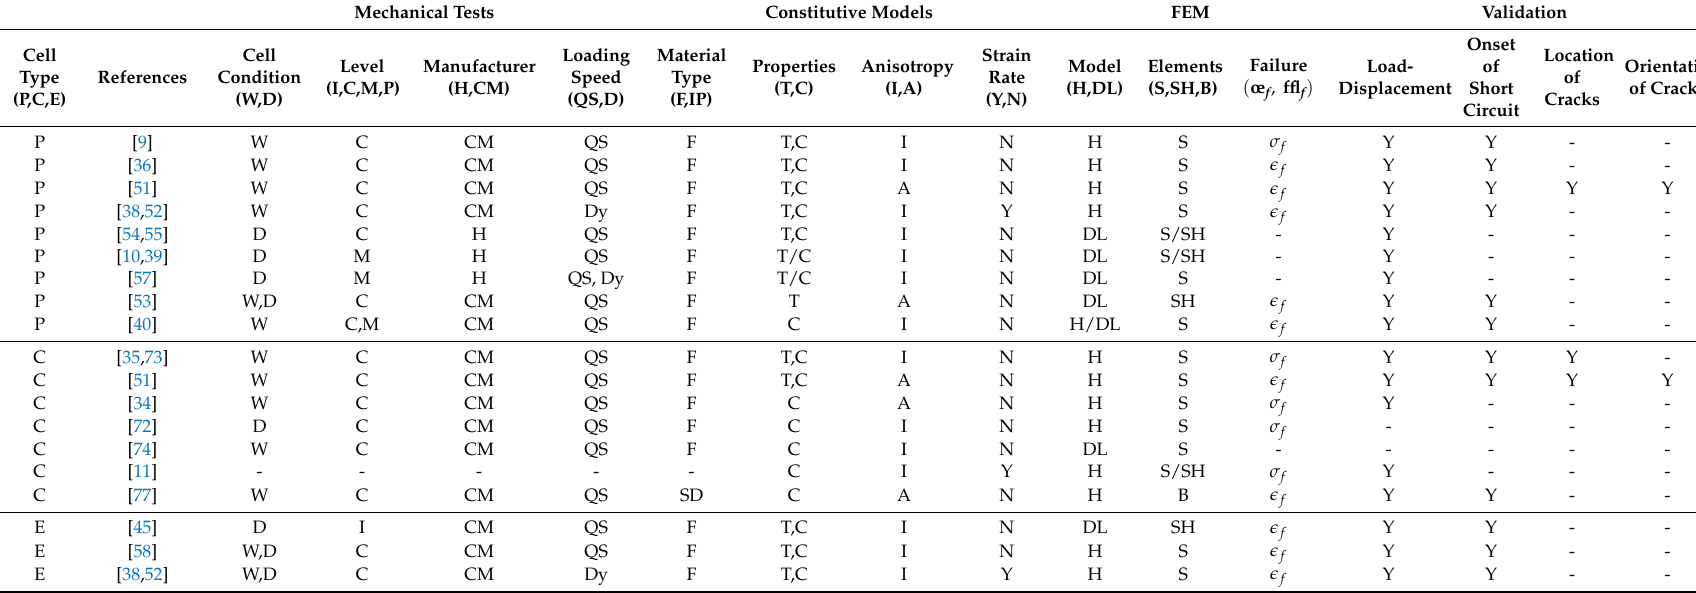
Table A1. Representative papers and their major properties of in mechanical characterization of Li-ion batteries. The notations here are following what presented in Figure